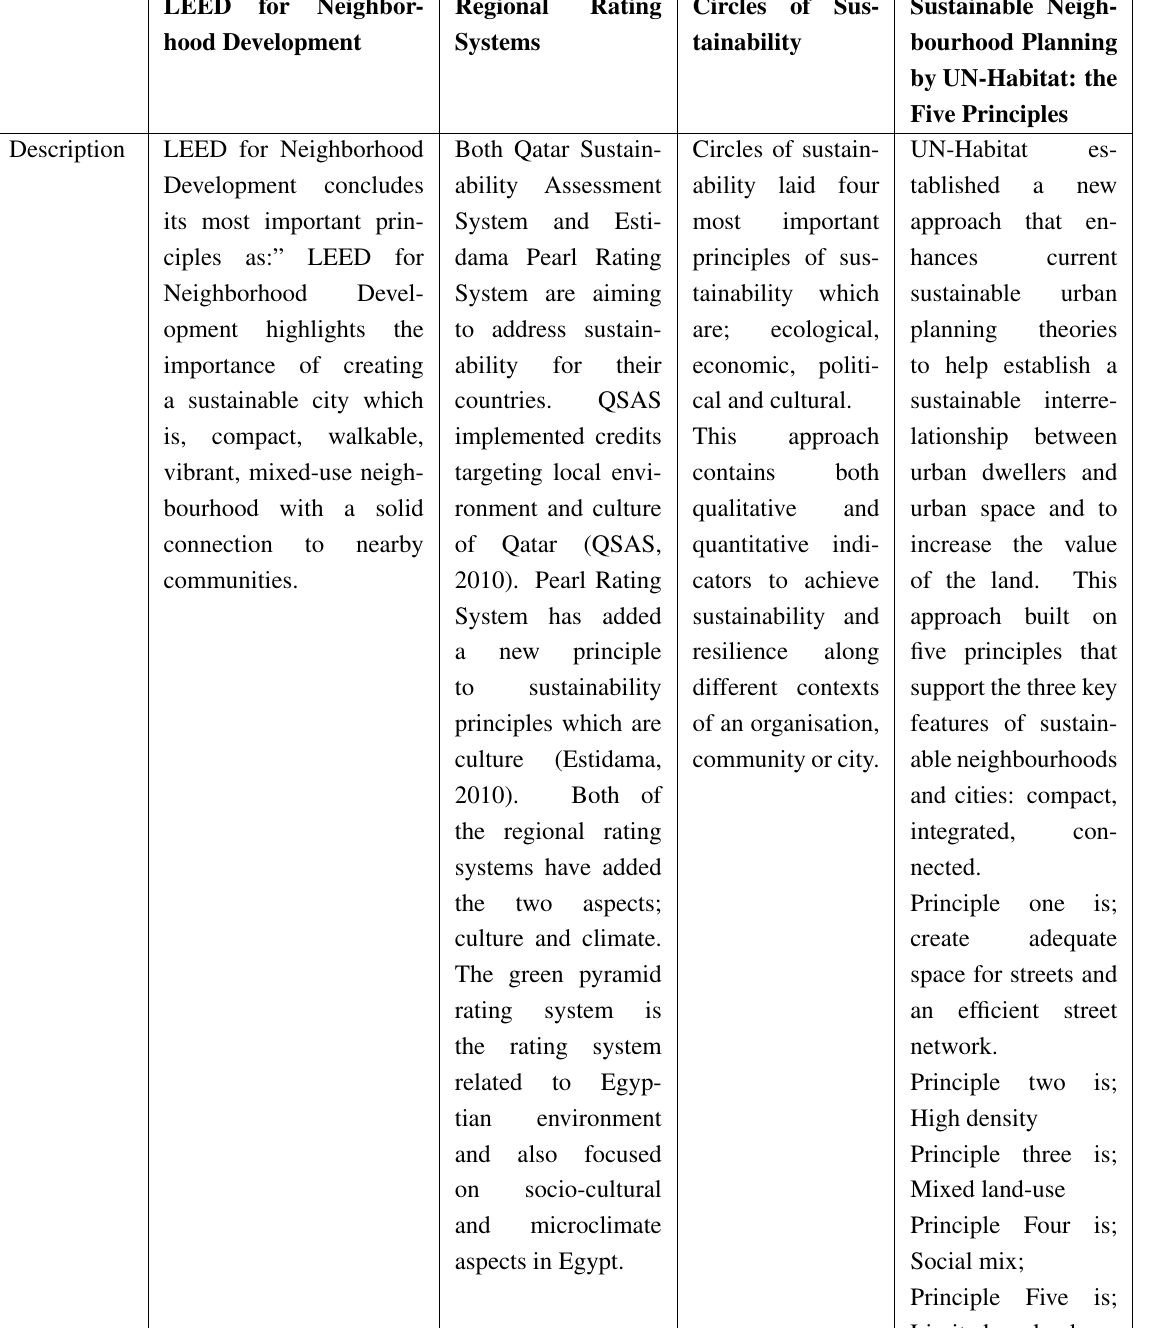
Table 1. comparison between sustainable neighbourhoods principles (Author,2017)